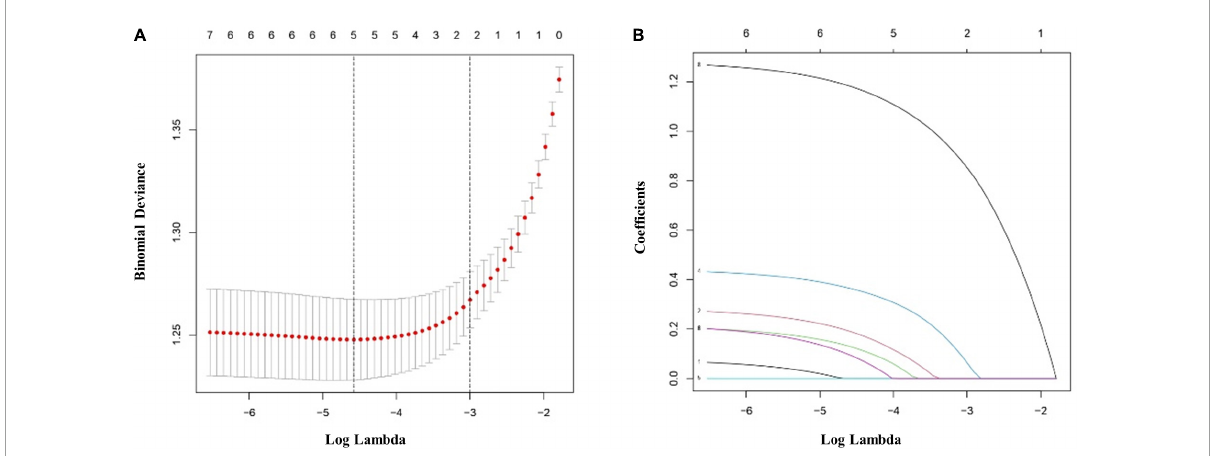
FIGURE4 Clinical and demographic ischemic stroke (IS) risk factors in the female population according to the least absolute shrinkage and selection operator (LASSO) binary logistic regression model. (A) Ten-fold cross-validation based on the minimum criterion was used to find the optimal parameter (lambda) selection for the LASSO model. A plot of the partial likelihood deviance (binomial deviance) curve versus log(lambda) is shown. The dashed vertical lines were plotted based on the optimal minimum criteria and 1-SE of the minimum criteria (1-SE criteria). (B) The eight feature LASSO coefficient profiles. A coefficient profiler was generated based on the log(lambda) sequence. A vertical line was plotted using the value chosen by the tenfold cross-validation. The optimal lambda was defined as the value that yielded non-zero coefficients for all eight features. (SE, standard error; LASSO, least absolute shrinkage and selection operator).